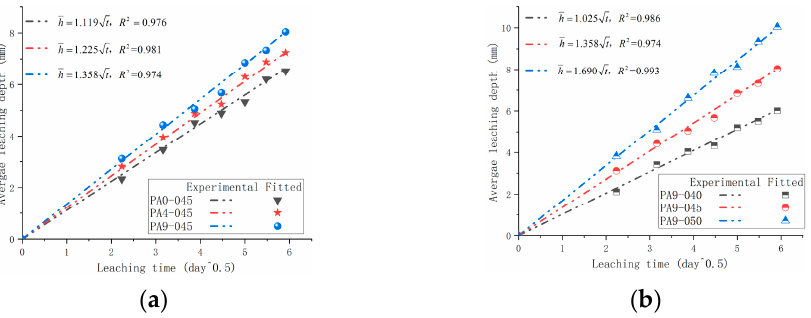
√ t for samples in 6M NH 4 Cl